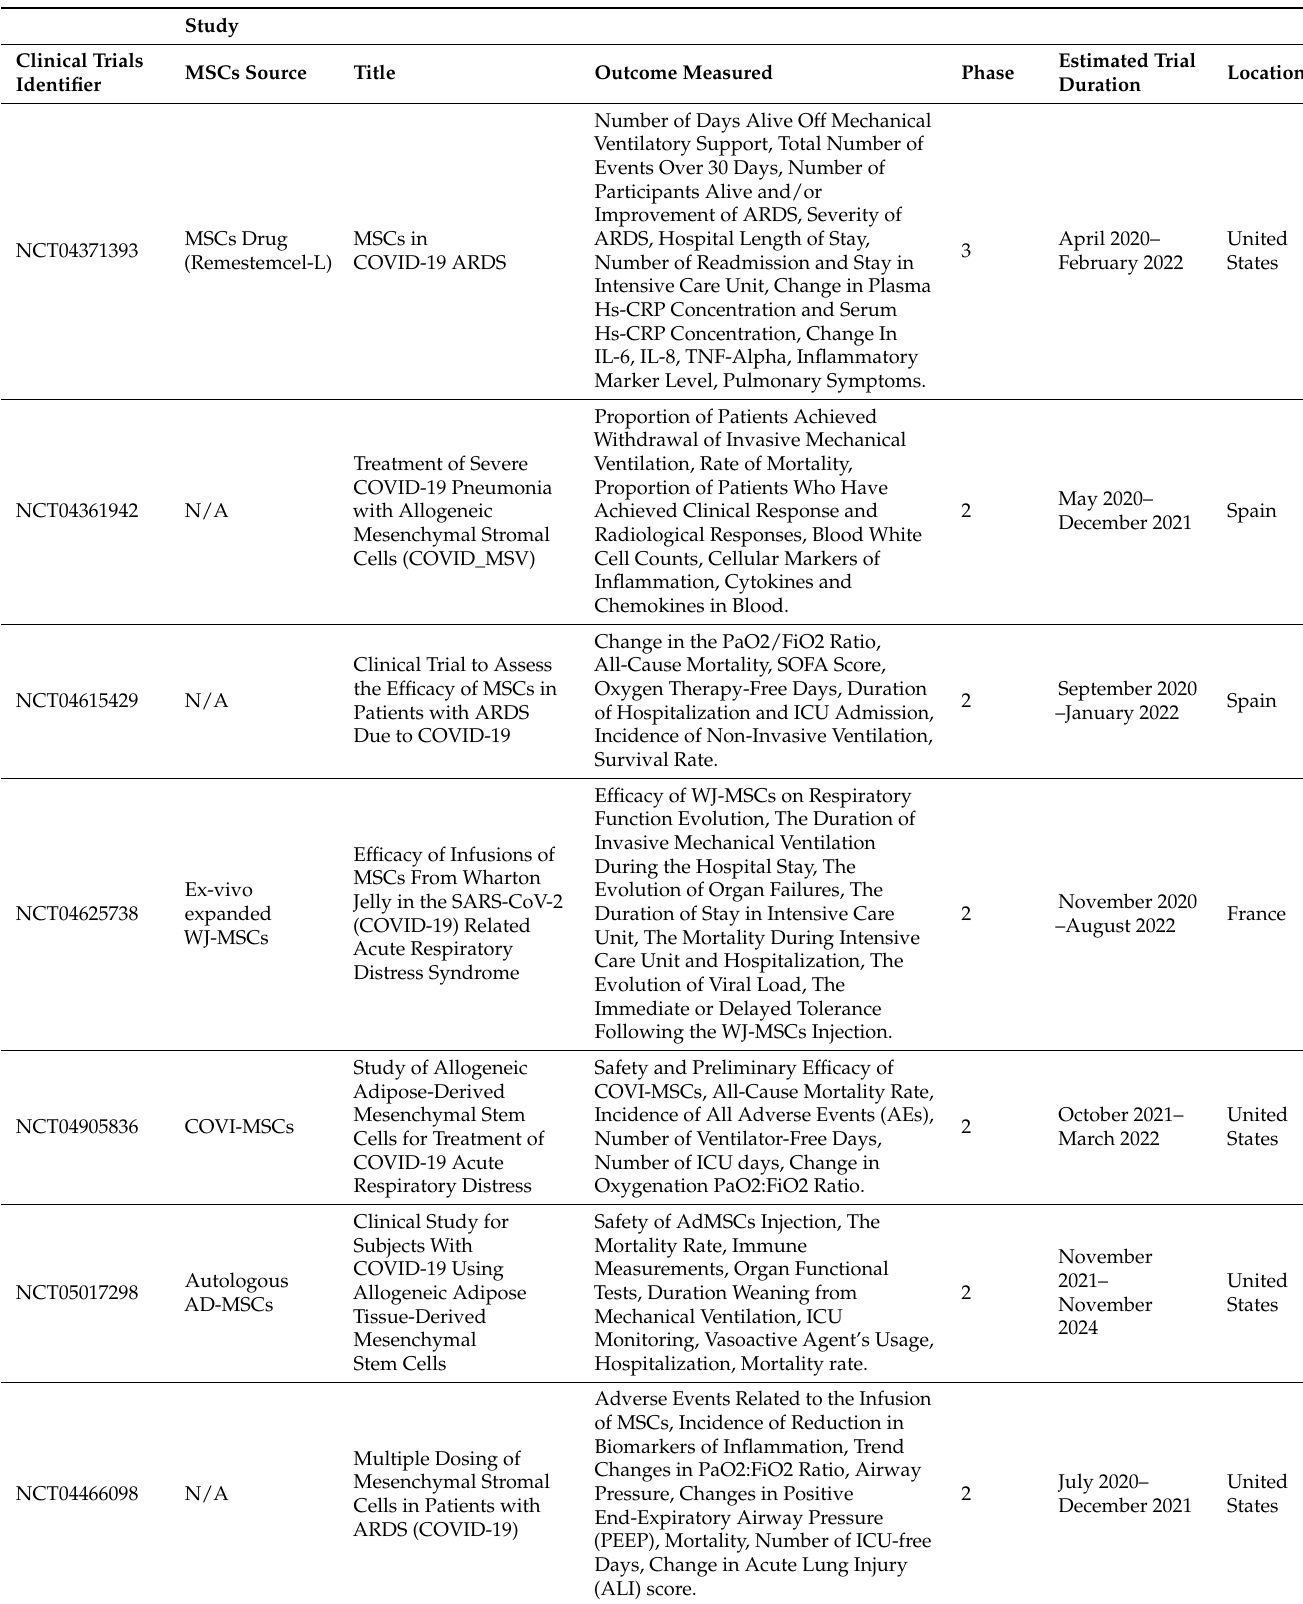
Table 5. Active clinical trials of MSCs usage for the treatment of